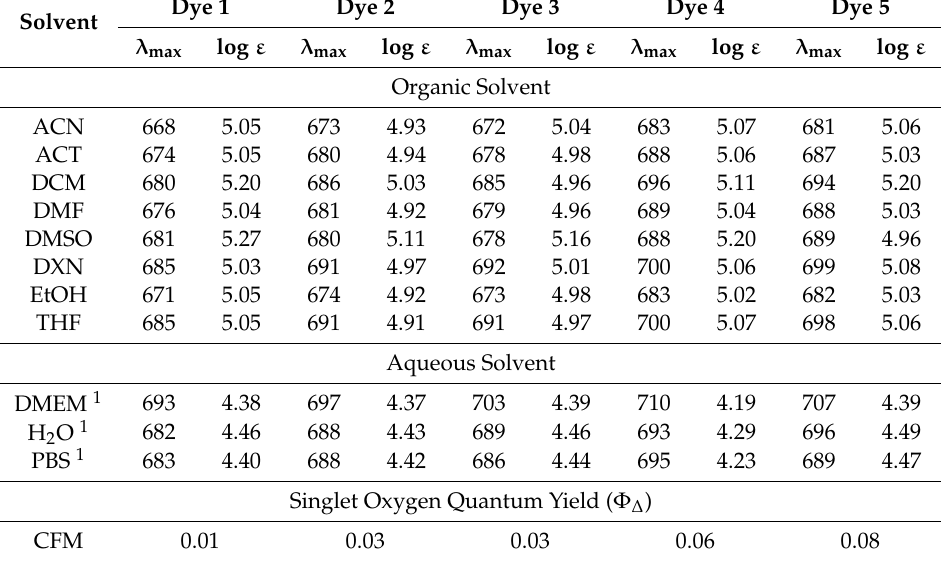
Table 1. Summary of data obtained in the visible and near-infrared spectroscopy of dicyanomethylene squaraine dyes 1 – 5 in acetonitrile (ACN), acetone (ACT), dichloromethane (DCM), dimethylformamide (DMF), dimethyl sulfoxide (DMSO), 1,4-dioxane (DXN), ethanol (EtOH), tetrahydrofuran (THF), serum-free Dulbecco’s Modified Eagle Medium (DMEM), water and phosphate-bu ff ered saline (PBS) ( λ max in nm). Singlet oxygen quantum yields ( Φ ∆ ) of the dyes in chloroform (CFM), determined using phenazine as